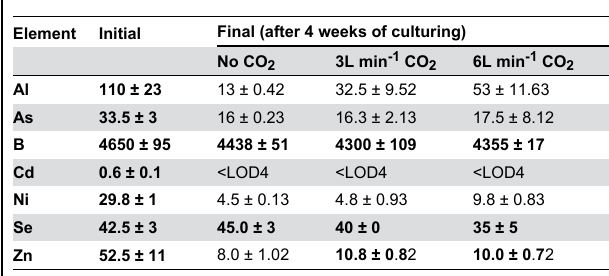
Table 2. Concentration of metals and metalloids in Ash Dam Water before and after the four week experiment under different CO addition regimes. 2